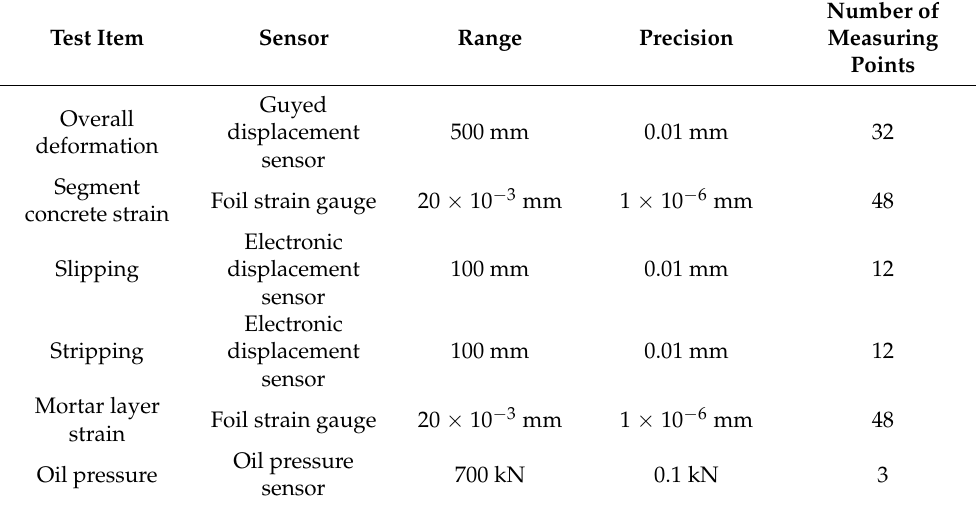
Table 2. Summary of measuring points.